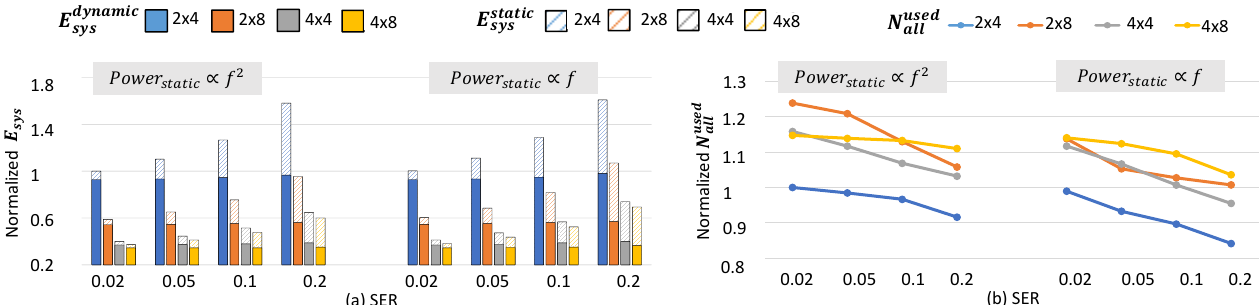
Figure 4. ( a ) Normalized E sys (i.e., E dynamic sys + E static sys , in #LCM = 100) and ( b ) normalized number of used cores (with regard to 2 × 4 platform, SER = 0.02) in all common feasible use cases (1002 use cases) by using the exhaustive strategy. Results are given for different platform sizes and different static energy models ( Power static ∝ f 2 and Power static ∝ f ) under constraints of increasing